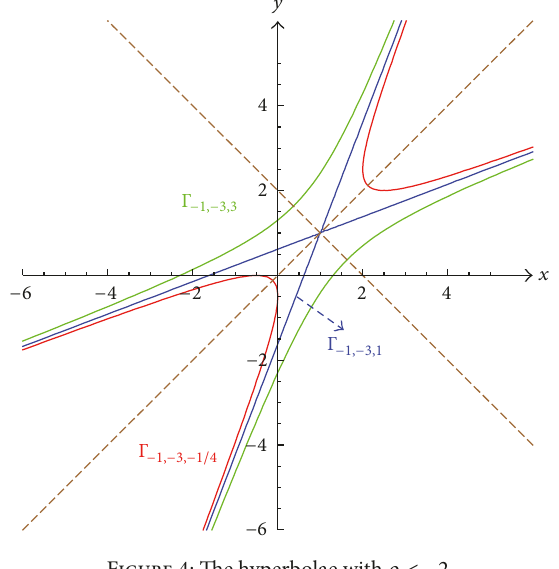
Figure 4: The hyperbolae with 𝜌 < −2 .